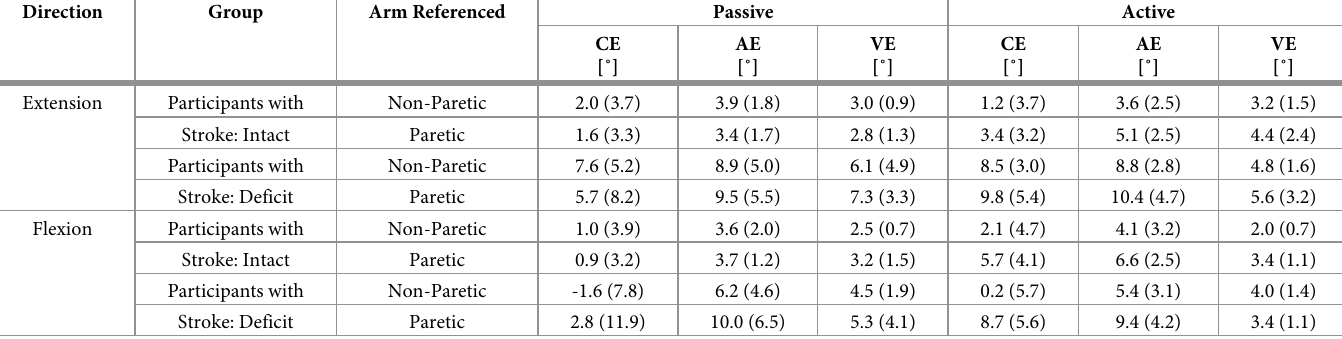
Table 3. Summarized errors. Reported for each classified group of participants when referencing each arm during passive and active movements are the mean (standard deviation) of the constant error, absolute error, and variable error. Direction